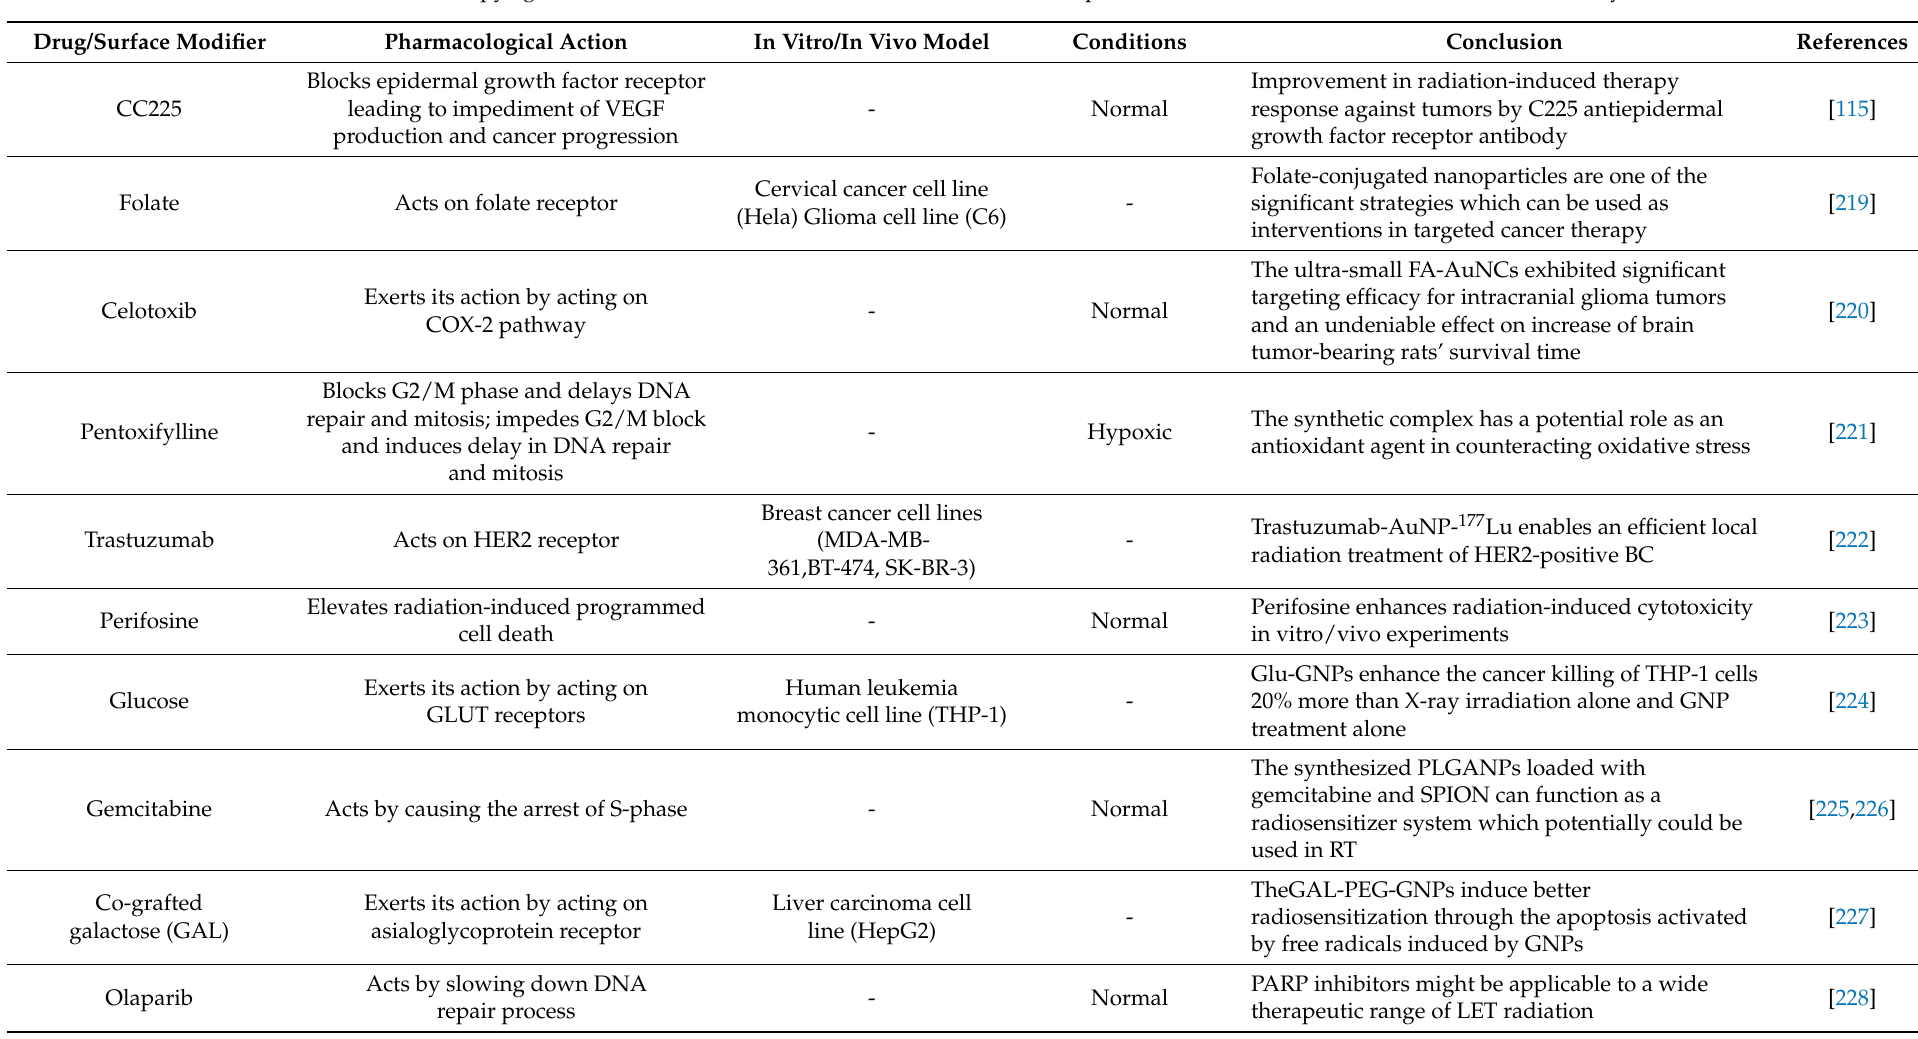
Table 2. Surface-modified nanoparticles with active targeting drugs/other radiosensitizing agents to enhance the combinatorial implications when combined with radiation therapy against cancer cells to maximize cancer cell ablation, ROS production, and to enhance the radiation dose